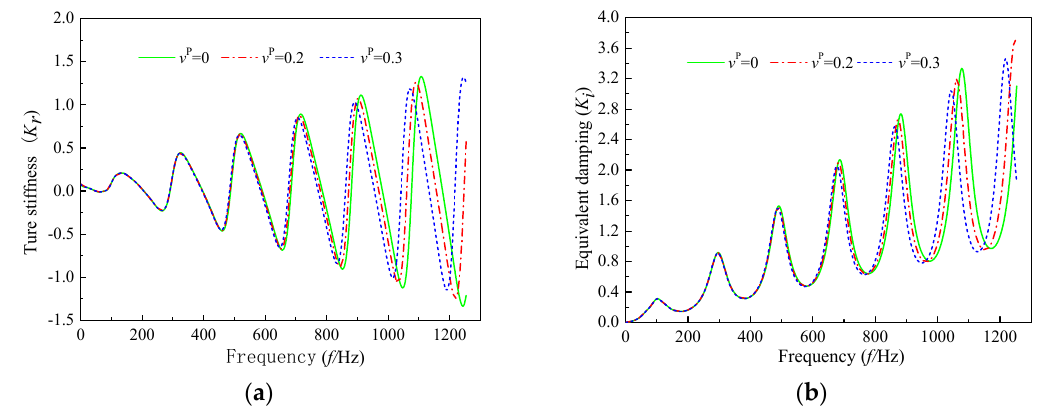
Figure 5. The effect of Poisson's ratio of pile shafts on the longitudinal impedance of pile shafts: ( a ) Figure 5. The e ff ect of Poisson’s ratio of pile shafts on the longitudinal impedance of pile shafts: ( a ) true true stiffness; ( b ) equivalent damping. sti ff ness; ( b ) equivalent